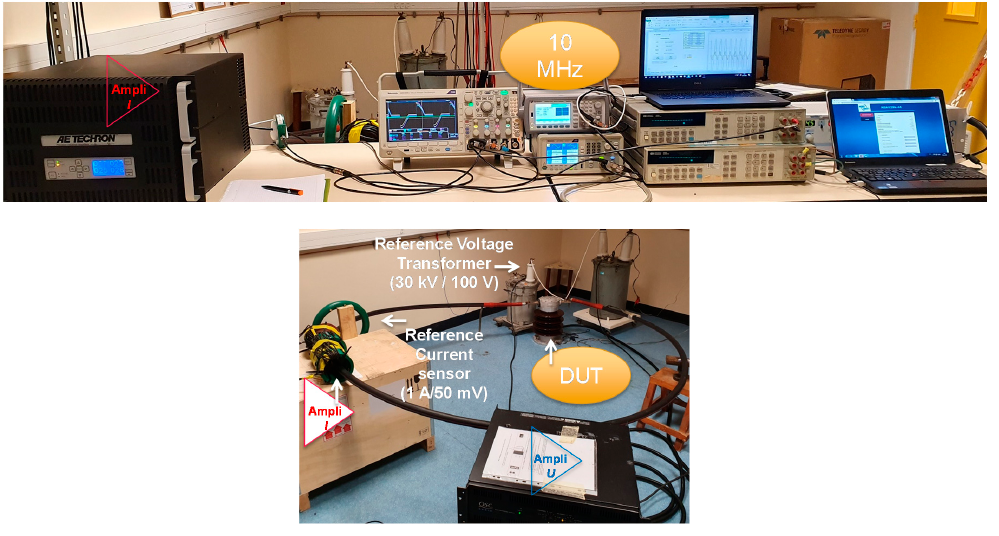
Figure 3. Principle scheme of the LNE current generation and fictive power source. This setup allows generating high currents with important harmonic content if the operation point of the injection current transformer, ICT, is optimized. This assumes finding a compromise between the transformation ratio, the impedances of the primary and secondary circuits, as well as the power supply mode of the transformer in order to avoid saturation of its magnetic core.